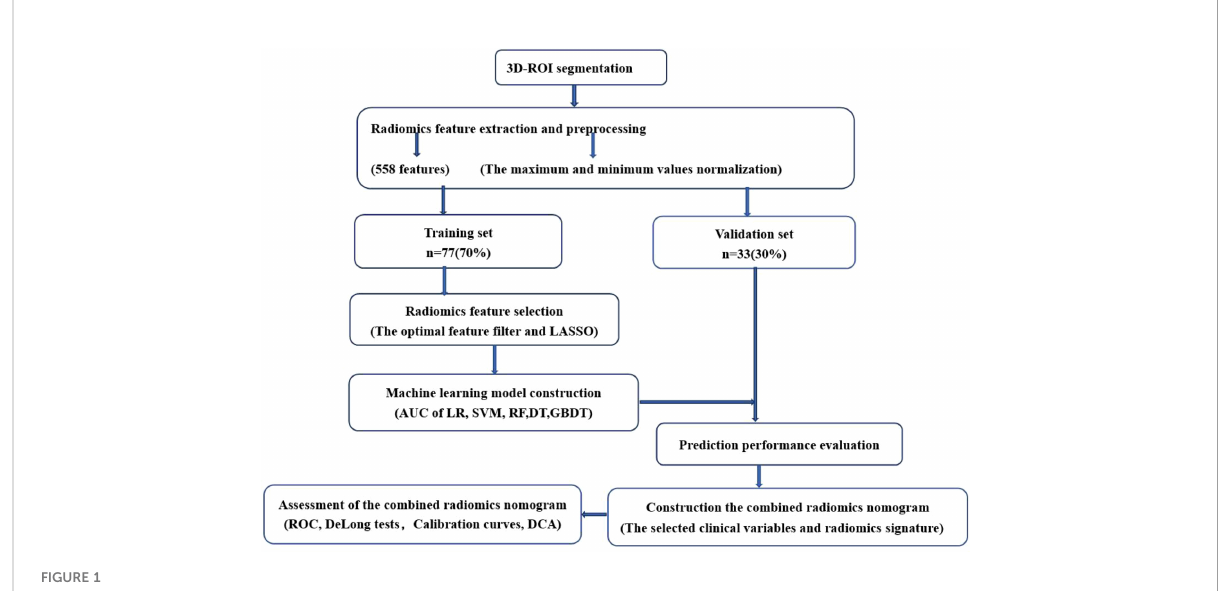
FIGURE 1 Radiomics work fl